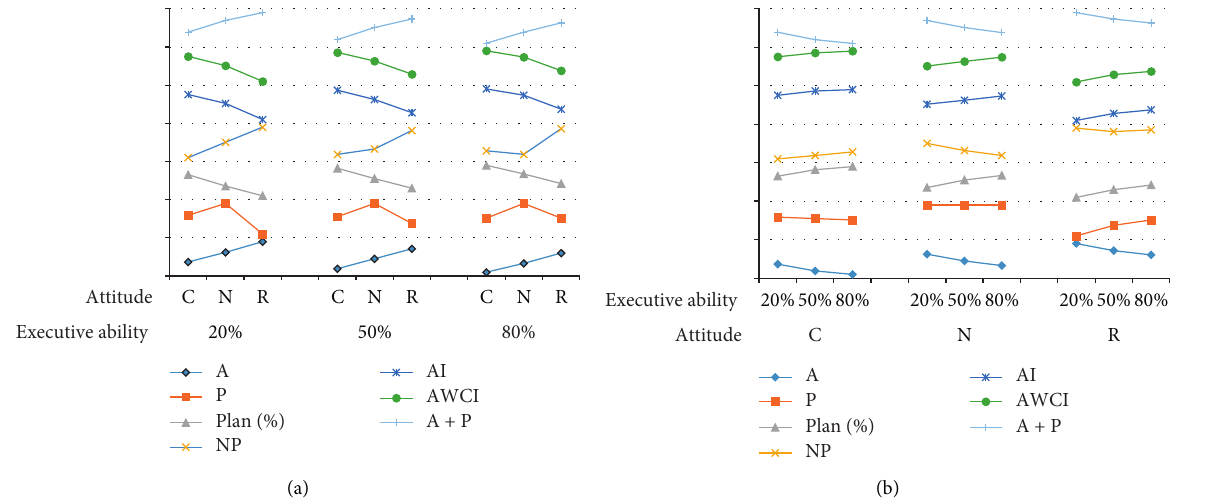
Figure 5: Index comparison under different risk preferences and executive ability of planning (in the situation of unreasonable planning). Notes: the downward broken line indicates decrease; otherwise, it indicates